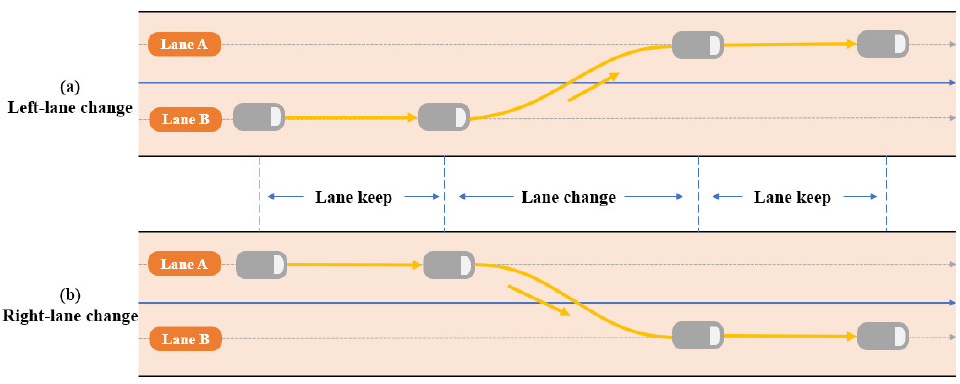
Figure 11. Third-order Bezier curve channel change model.